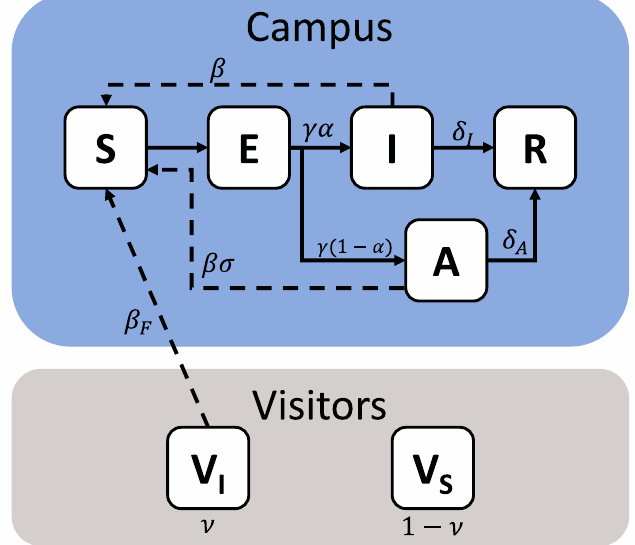
Figure 1. Schematic representation of a model of COVID-19 transmission due to in-person sporting events. The campus population is shown within the blue field, while visitors are shown within the grey field. The campus population can take five health states—Susceptible (S), Exposed (E), Infectious (I), Asymptomatic (A) or Removed (R), while visitors are represented as two states, Susceptible (V S ) or Infectious (V I ). Solid arrows denote transition terms, while dashed arrows denote potential transmission pathways. The relevant parameters for each are also shown. Table 1. Transitions and equations for a model of COVID-19 transmission due to in-person sport- ing